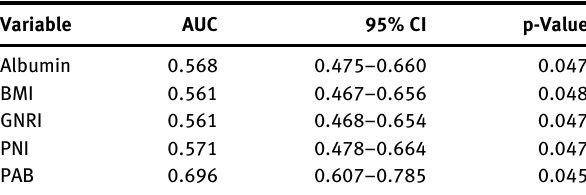
Table  : Performance of independent